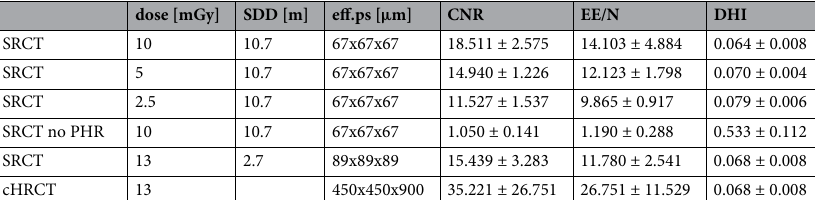
Table 1. Quantitative comparison of the different imaging techniques and